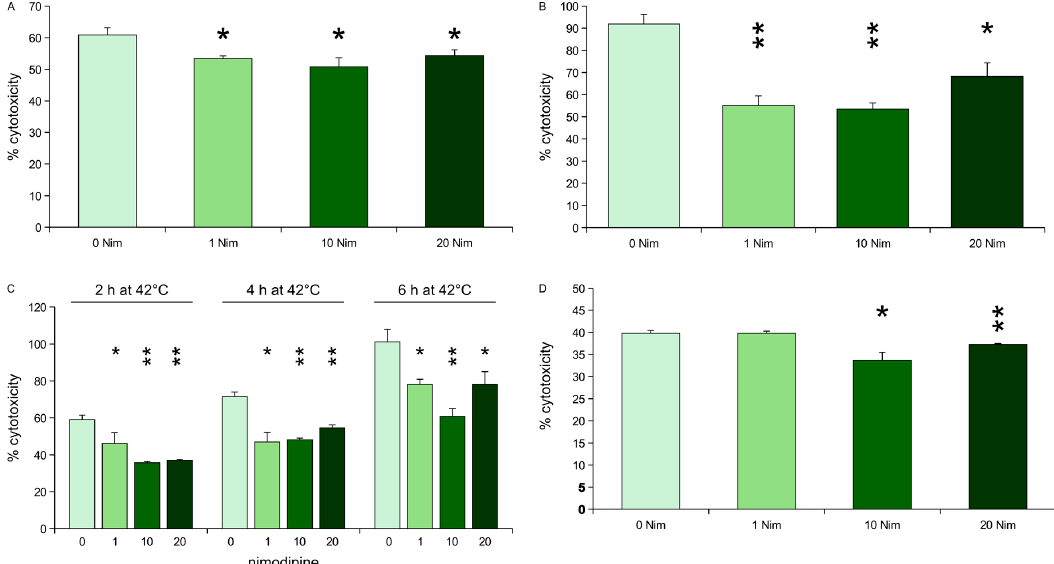
Figure 1. Lactate dehydrogenase (LDH) activity measurement after stress on differentiated, nimodipine pre-treated Neuro2a cells. Values are given as the mean ± SD (error bars) of one representative out of at least three biologically independent experiments. Nim = nimodipine (in μ M); single asterisk = p < 0.05 compared to non-treated cells; double asterisks = p < 0.005 compared to non-treated cells. ( A ) Oxidative stress (EtOH, 2%); ( B ) osmotic stress (NaCl, 150 mM); ( C ) heat stress (4 or 6 h at 42 °C, respectively); ( D ) mechanical stress.